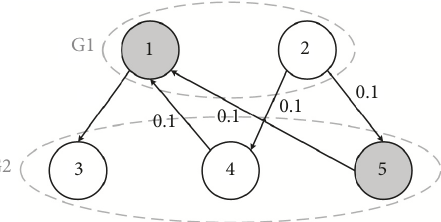
Figure 1: The bipartite digraph topology of the heterogeneous MASs.